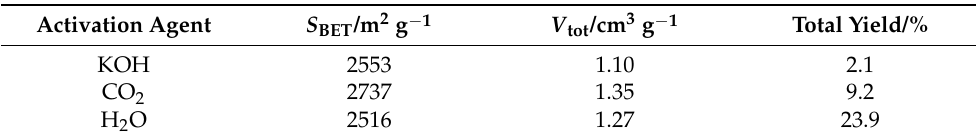
Table 1. Data on the porosity (specific surface area S BET and total pore volume V tot ) and the total yield of the